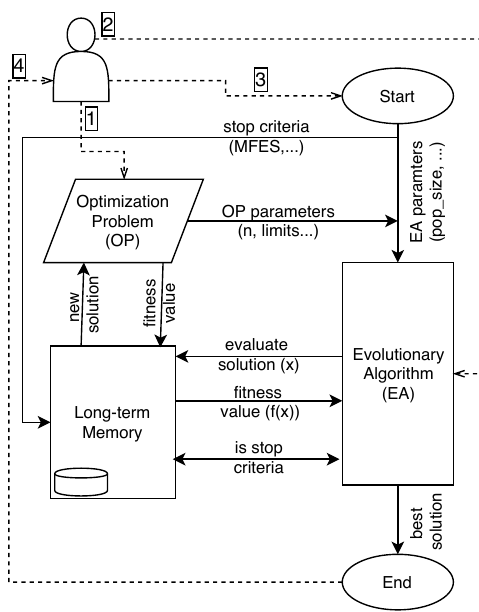
Figure 2. The implementation of